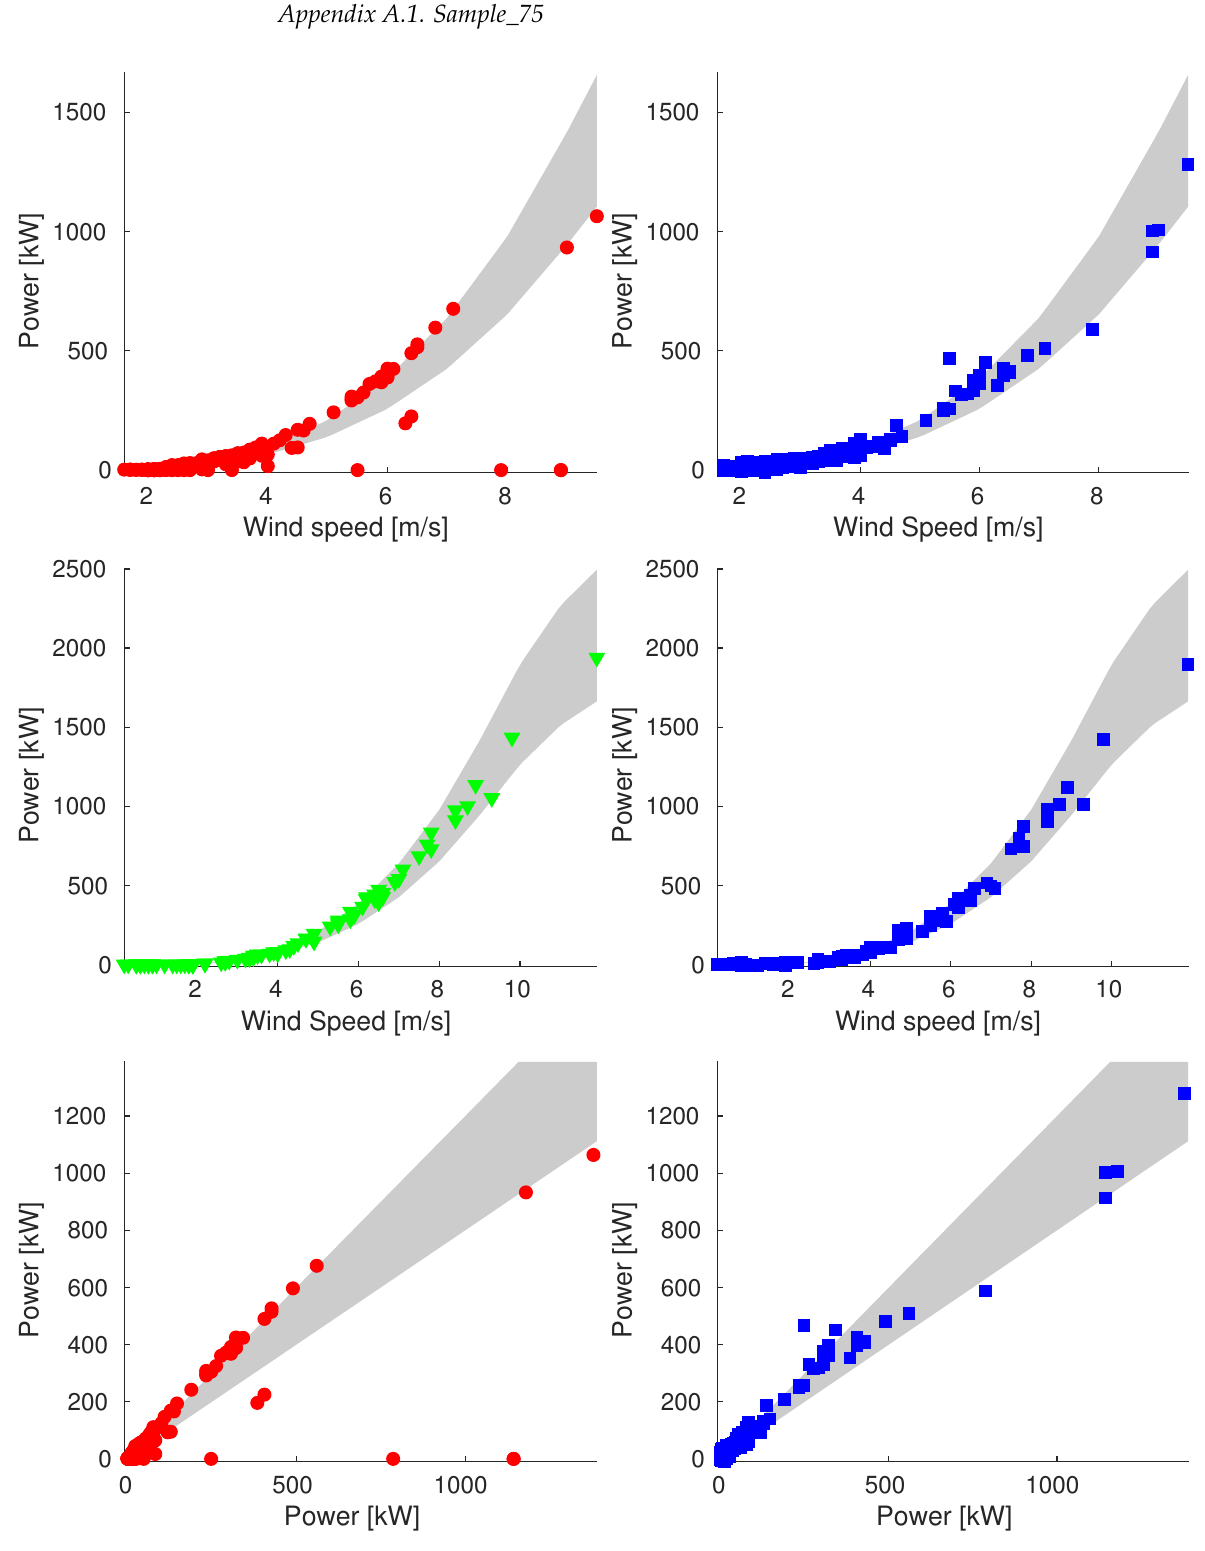
Figure A1. Plot of reconstructions for data points of 7 May ( Sample_75 ). We compare original data (on the left ) and reconstructed values (on the right ). We show plots of power vs. wind speed of rejected and validation data ( up and middle respectively) and plot of power vs. ideal power of rejected data ( bottom